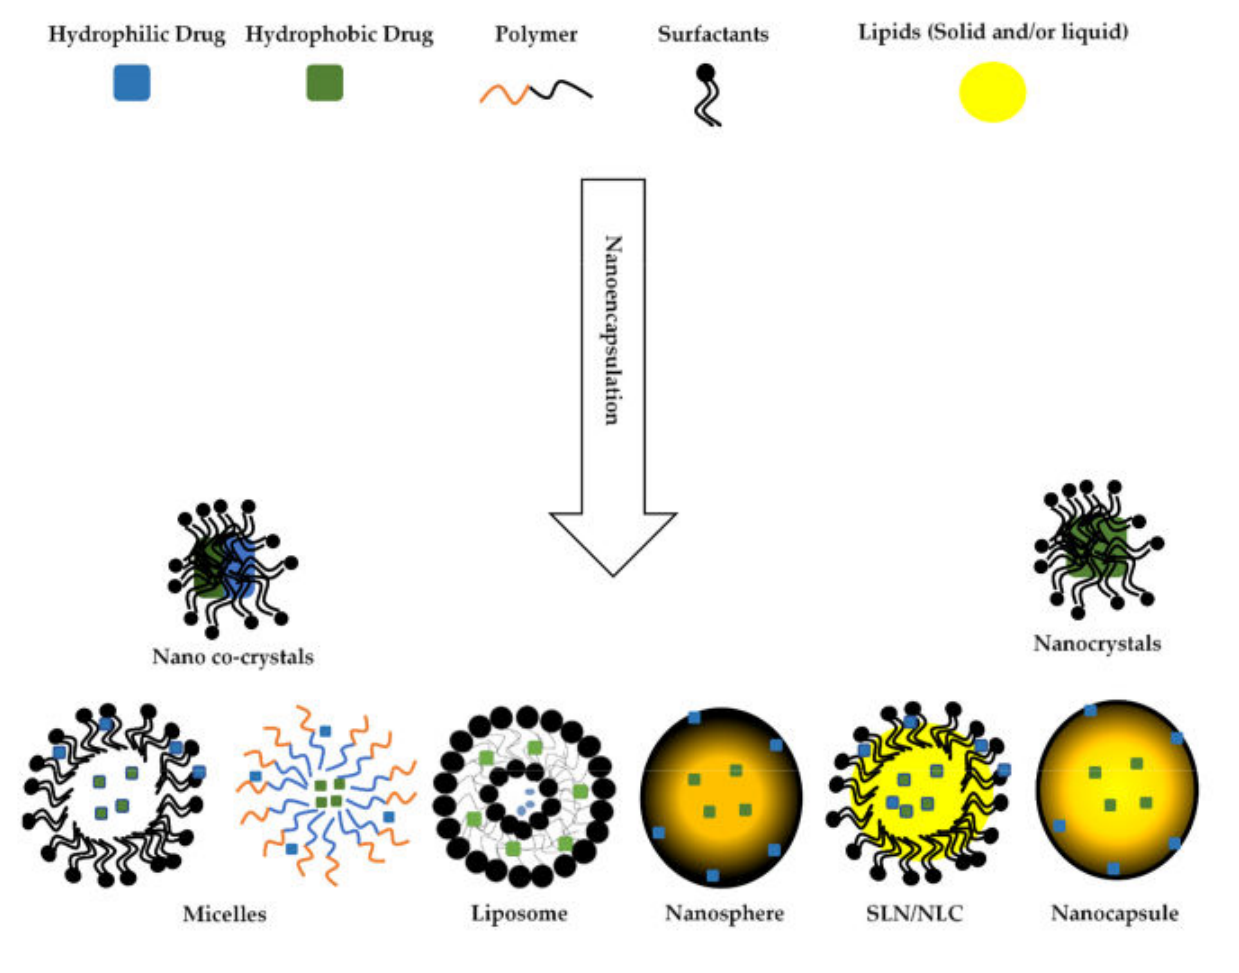
Figure 2. Schematic representation of various nano-encapsulated systems